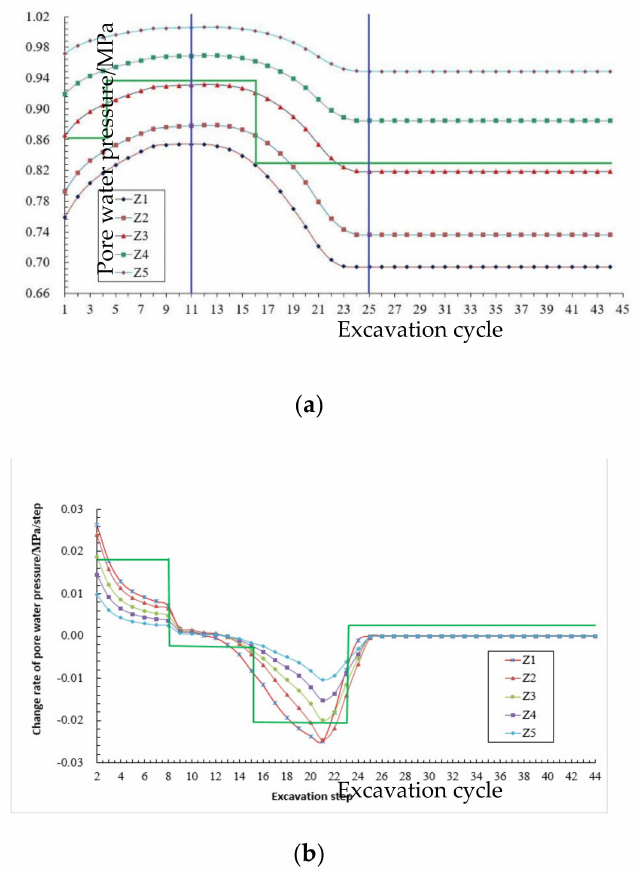
Figure 10. Pore water pressure curve and plot of the change rate of the pore water pressure at each monitoring point in the tunnel and the karst plastic zone with the advancement of excavation. ( a ) Pore water pressure at different excavation cycles for each monitoring point; ( b ) Change rate of the pore water pressure at each monitoring